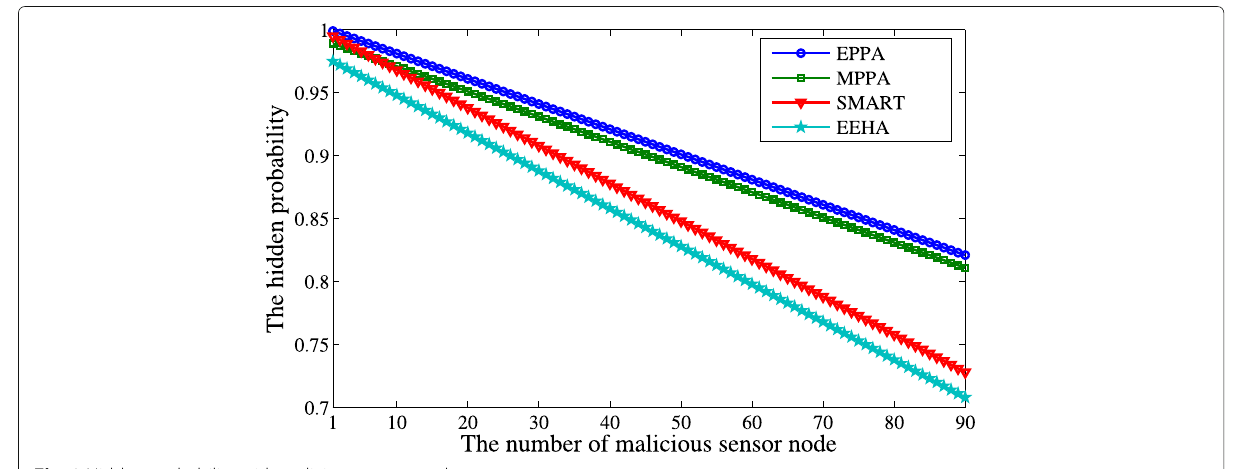
Fig. 9 Hidden probability with malicious sensor nodes